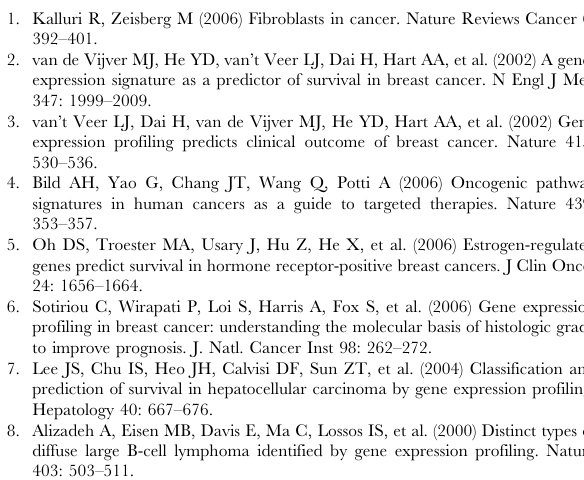
Figure S3 PathwayAssist TM -generated figure showing genes that are activated by interferon c and show significantly increased expression in the tumors from patients in the WORST prognosis group compared to those in the BEST prognosis group. Figure S4 PathwayAssist TM -generated figure showing genes that are activated by IL-4 and show significantly increased expression in the tumors from patients in the WORST prognosis group compared to those in the BEST prognosis group. Figure S5 PathwayAssist TM -generated figure showing genes that are activated by cyclin A2 and show significantly increased expression in the tumors from patients in the WORST prognosis group compared to those in the BEST prognosis group. Figure S6 PathwayAssist TM -generated figure showing genes that are activated by tumor necrosis factor and show significantly increased expression in the tumors from patients in the WORST prognosis group compared to those in the BEST prognosis group. Figure S7 PathwayAssist TM -generated figure showing genes that are activated by AKT1 and show significantly increased expression in the tumors from patients in the WORST prognosis group compared to those in the BEST prognosis group. Figure S8 Venn diagram that shows genes activated in common by EGF, IFN- c or IL-4. EGF expressed a total of 115 genes significantly more highly in tumors from the patients with the WORST prognosis group than in patients in the BEST prognosis group. Of these 115 genes, 26 are also activated by IL-4 and highly expressed in BEST tumors, and 16 of these are highly expressed in BEST patients’ tumors and activated by EGF, IL-4 and TNF. The genes activated by more that one of these three factors are listed in the overlapping sectors. Table S1 Functional enrichment analysis of PCT-TC signature genes. The enrichment of each gene set was estimated by calculating the cumulated hypergeometric p values of each biological process provided by Gene Ontology Consortium (www.gene-ontology.org). Gene annotation according to Gene